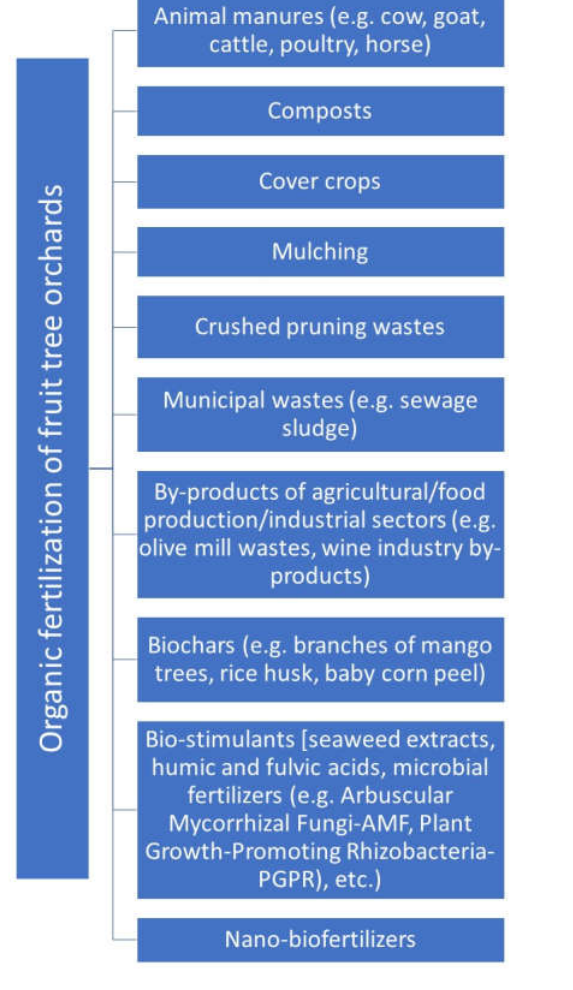
Figure 1. Categories/types of organic fertilizers for tree crops.